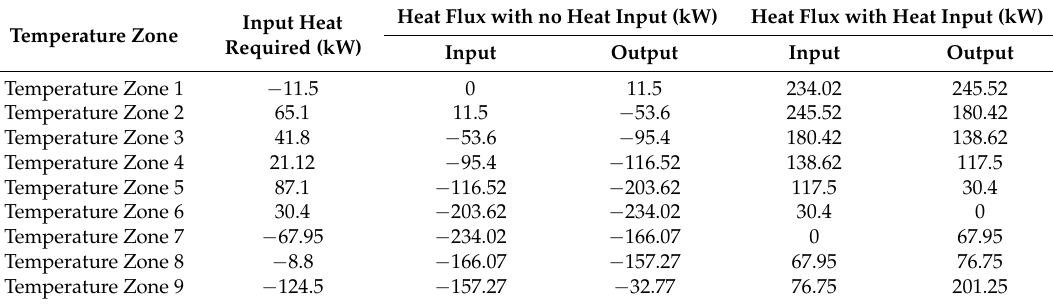
Table 2. Question table used to optimize pinch point